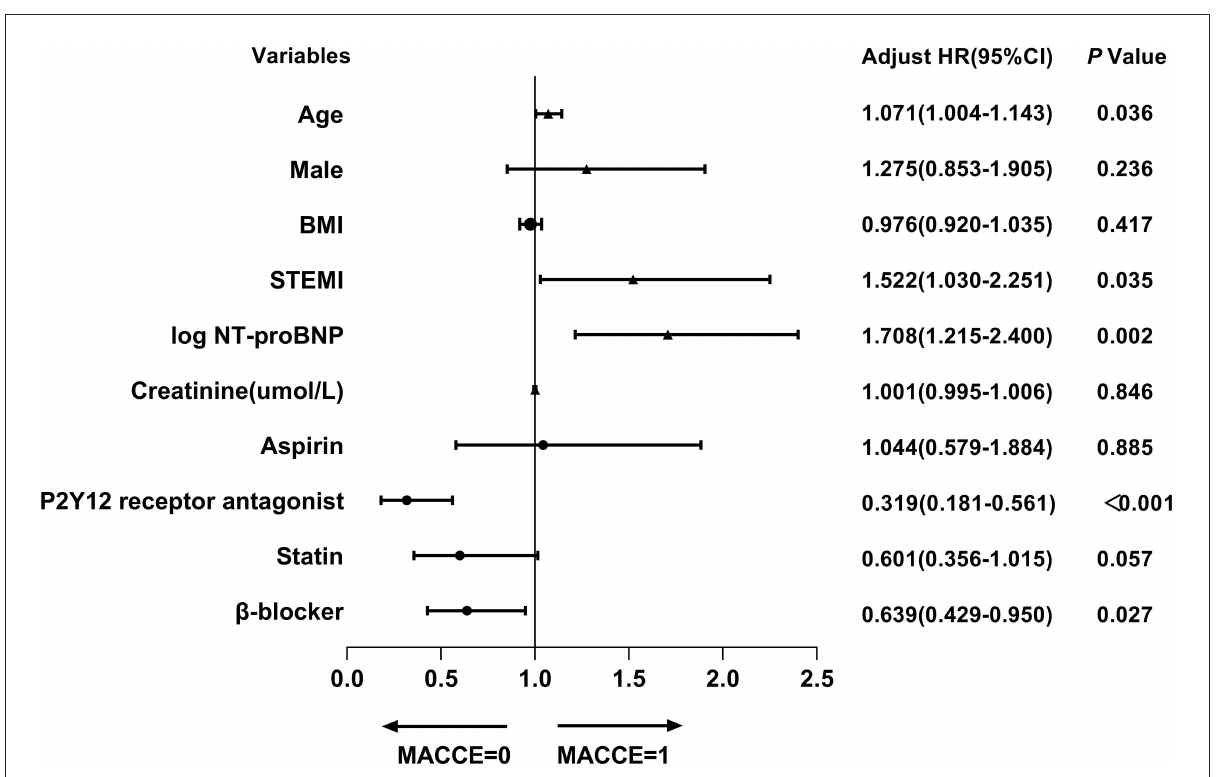
FIGURE3 Factors independently associated with composite MACCE in PCI group in multivariable Cox regression analysis. BMI, body mass index; STEMI, ST-elevation myocardial infarction; NT-proBNP, N-terminal pro-brain natriuretic peptide; PCI, percutaneous coronary intervention; MACCE, major adverse cardiovascular and cerebrovascular